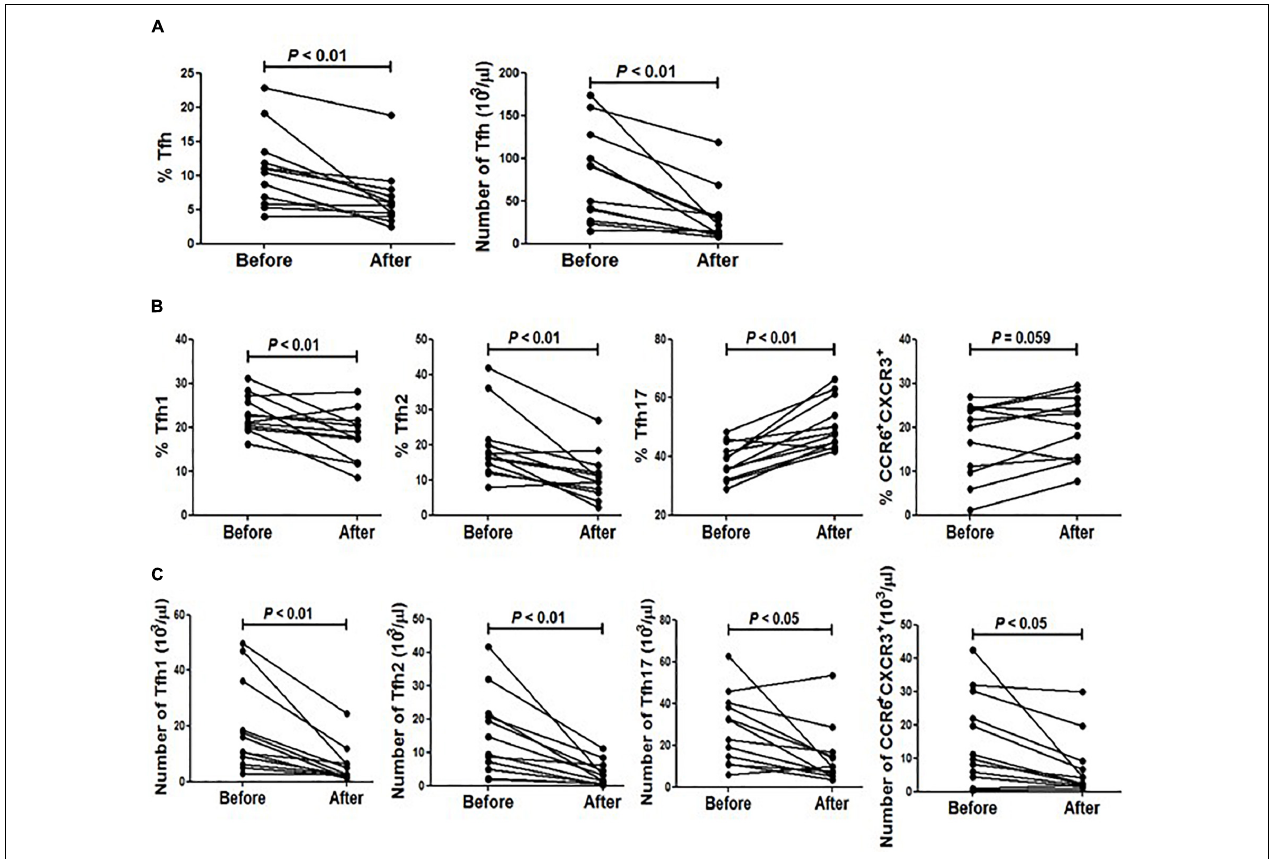
FIGURE 4 | The impact of methylprednisolone on circulating Tfh cells from SLE patients. (A) The frequency and absolute number of Tfh cells before and after methylprednisolone treatment were analyzed. (B) Frequencies of all Tfh subsets before and after methylprednisolone treatment were analyzed. (C) Absolute number of all Tfh subsets before and after methylprednisolone treatment was analyzed. All results are presented as mean ± standard error of the mean